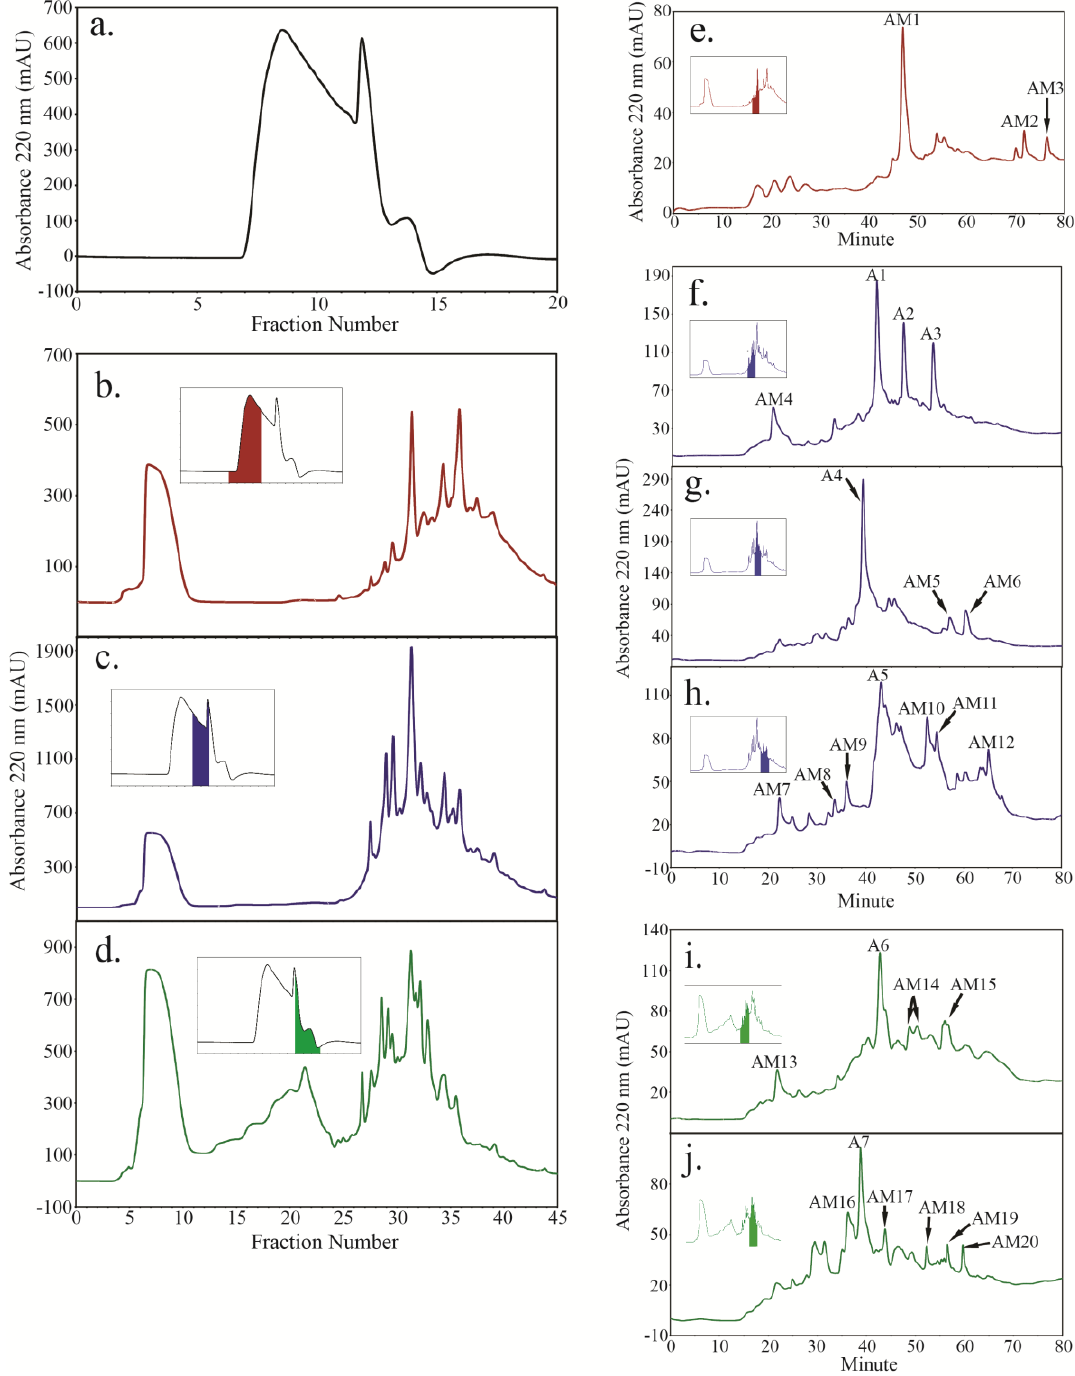
Figure 4. Peptides were isolated from trypsin digested ANP10 HFI using a combination of size exclusion chromatography (SEC) ( a ), strong cation exchange chromatography (SCX) ( b – d ) and reverse phase chromatography ( e – j ), also summarized in Figure 1. Color-coded inserts in panels b to d identify the SEC fractions taken in turn for further fractionation by SCX chromatography. Color-coded inserts in panels e to j identify the SCX fractions taken in turn for further peptide mapping by reverse phase chromatography. SCX fractions 35 to 37 in ( b ) and fractions 34 to 37 in ( d ) failed to yield any peptide peaks on further fractionation by reverse-phase HPLC. The major peptide peaks (A220 > 100) from the ANP10 HFI are labeled with “A” while minor peptides are labeled as